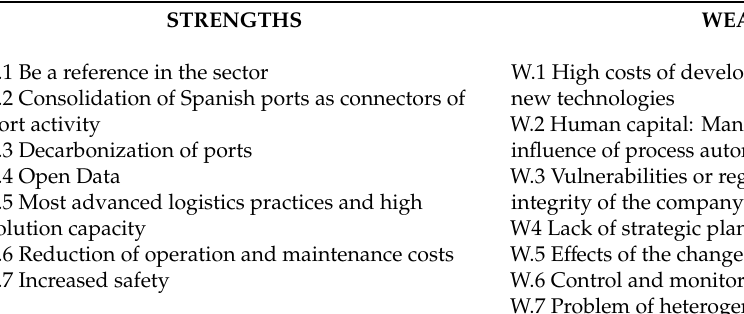
Table 1. SWOT Matrix (Strengths-Weaknesses-Opportunities-Threats